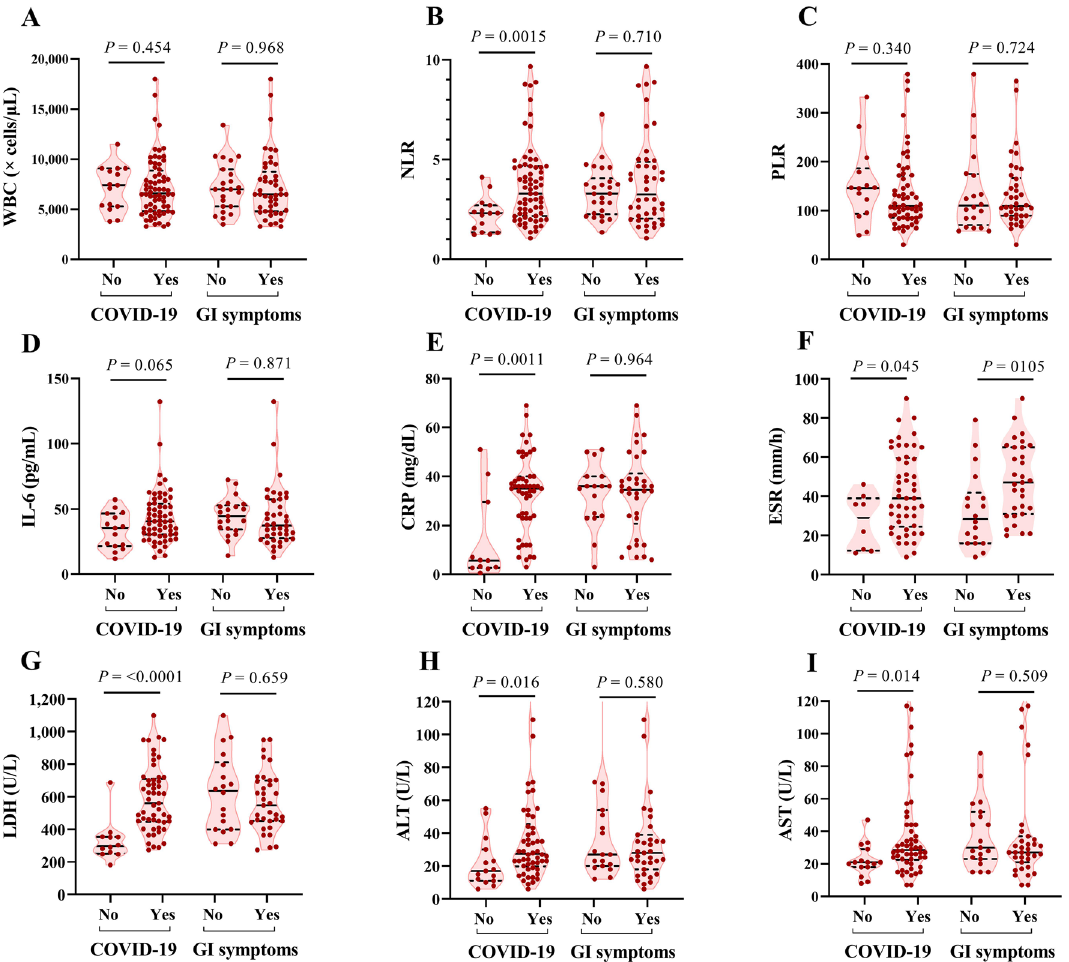
Figure 2. Laboratory findings of COVID-19 and healthy individuals. Hematology and biochemistry markers in COVID-19 patients compared with control. Comparisons between patients with and without GI symptoms are also shown. The median and the interquartile ranges are represented on violin plots. Each point indicates a value of a patient. The P values calculated using the Mann–Whitney test and Welch t-test with significance defined as P <